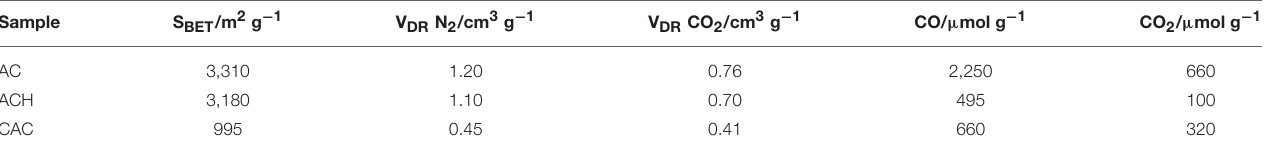
TABLE 3 | Porous texture and surface chemistry characterization of all samples.